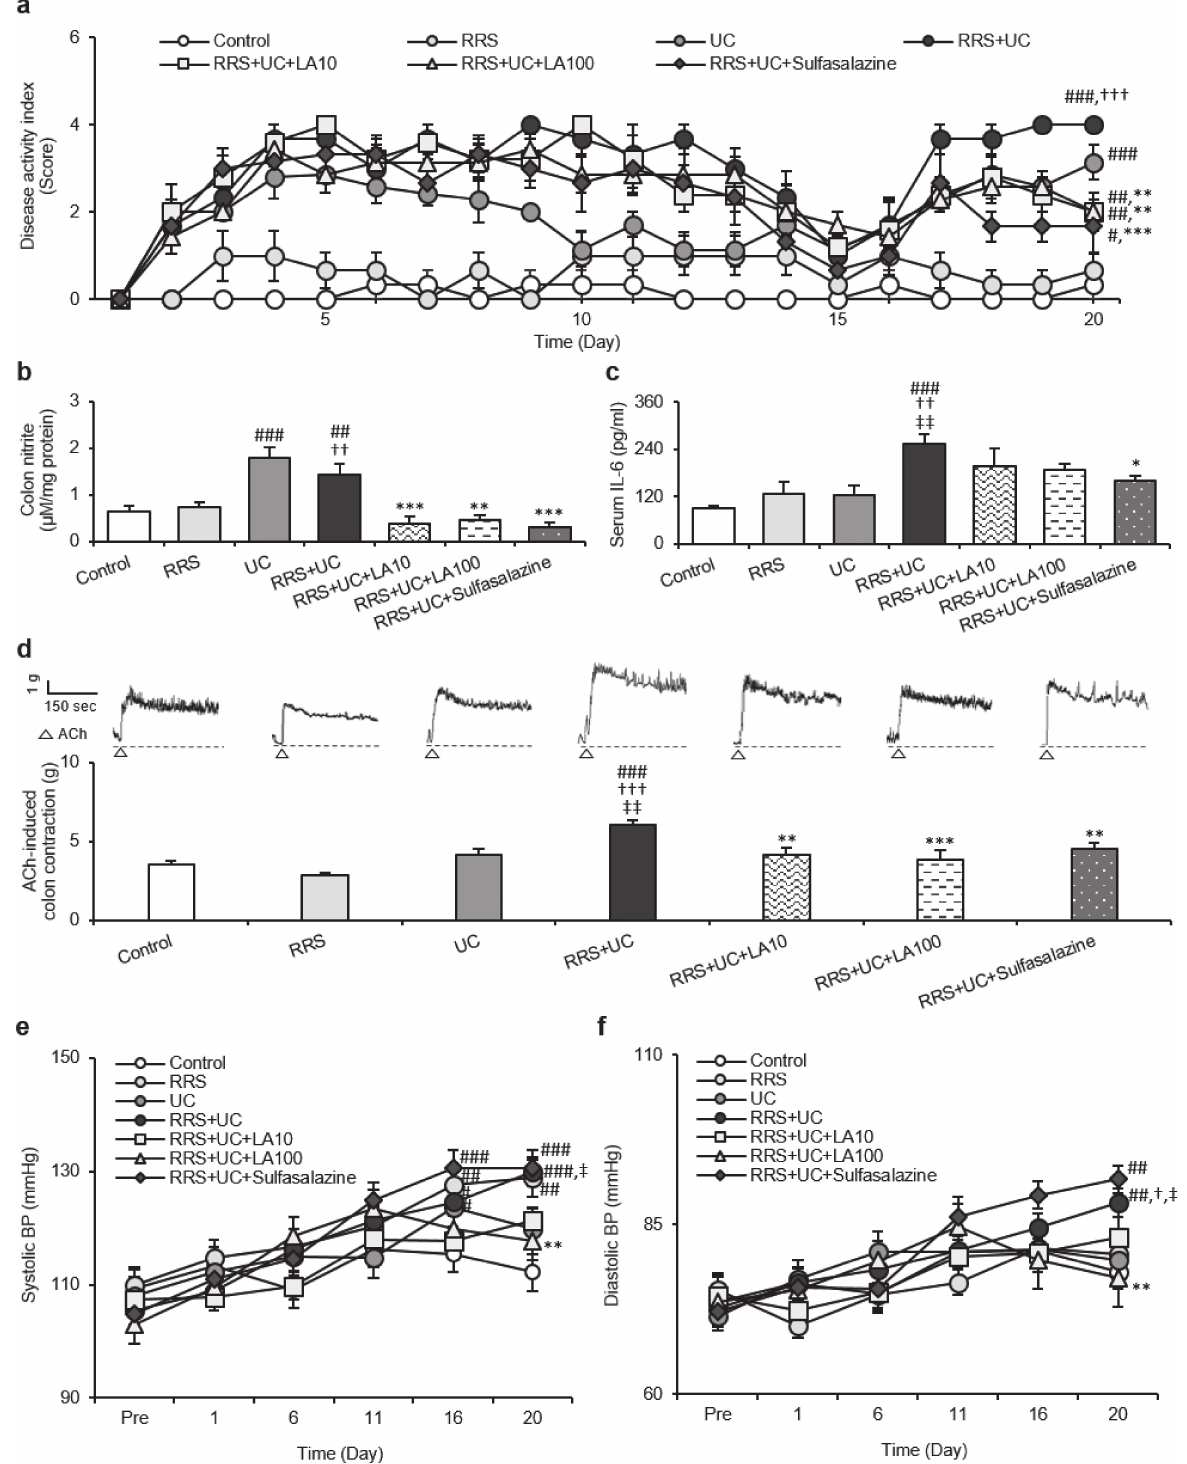
Fig. 2 E ff ects of LA on factors a ff ecting colon contractility and BP in repeatedly stressed-UC rats. (a) Disease activity index. (b) Nitrite levels in colon tissue. (c) Serum IL-6 levels. (d) Acetylcholine-induced colon contraction. (e) Systolic BP. (f) Diastolic BP. Results are presented as mean + SEM. DAI data were analyzed by repeated measures ANOVA and one-way ANOVA using data from day 20. BP data were analyzed using one-way ANOVA at each time point followed by a post-hoc LSD test. # P < 0.05, ## P < 0.01, ### P < 0.001 vs. Control; † P < 0.05, †† P < 0.01, ††† P < 0.001 vs. RRS; ‡ P < 0.05, ‡‡ P < 0.01 vs. UC; * P < 0.05, ** P < 0.01, *** P < 0.001 vs. RRS + UC. ACh, acetylcholine; BP, blood pressure; IL, interleukin; LA, linalyl acetate; RRS, restraint stress; UC, ulcerative